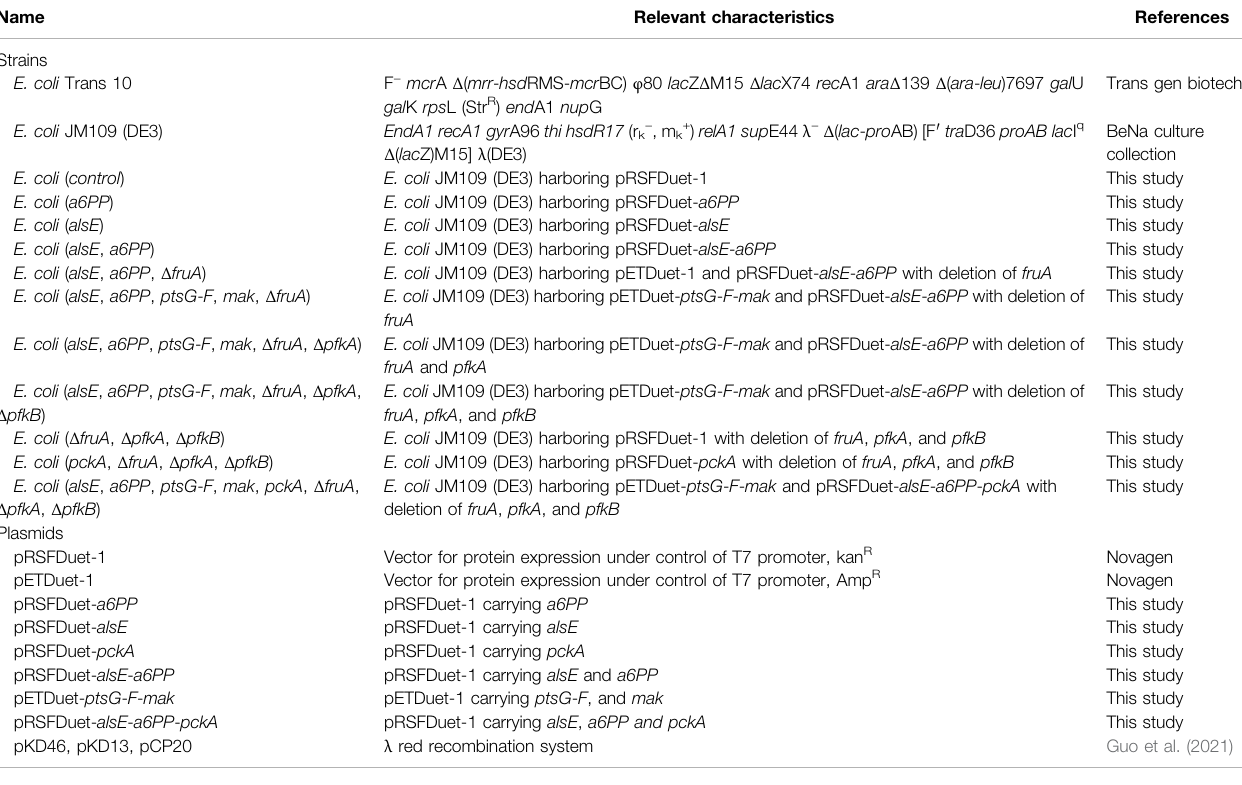
TABLE 1 | The strains and plasmids used in this study.